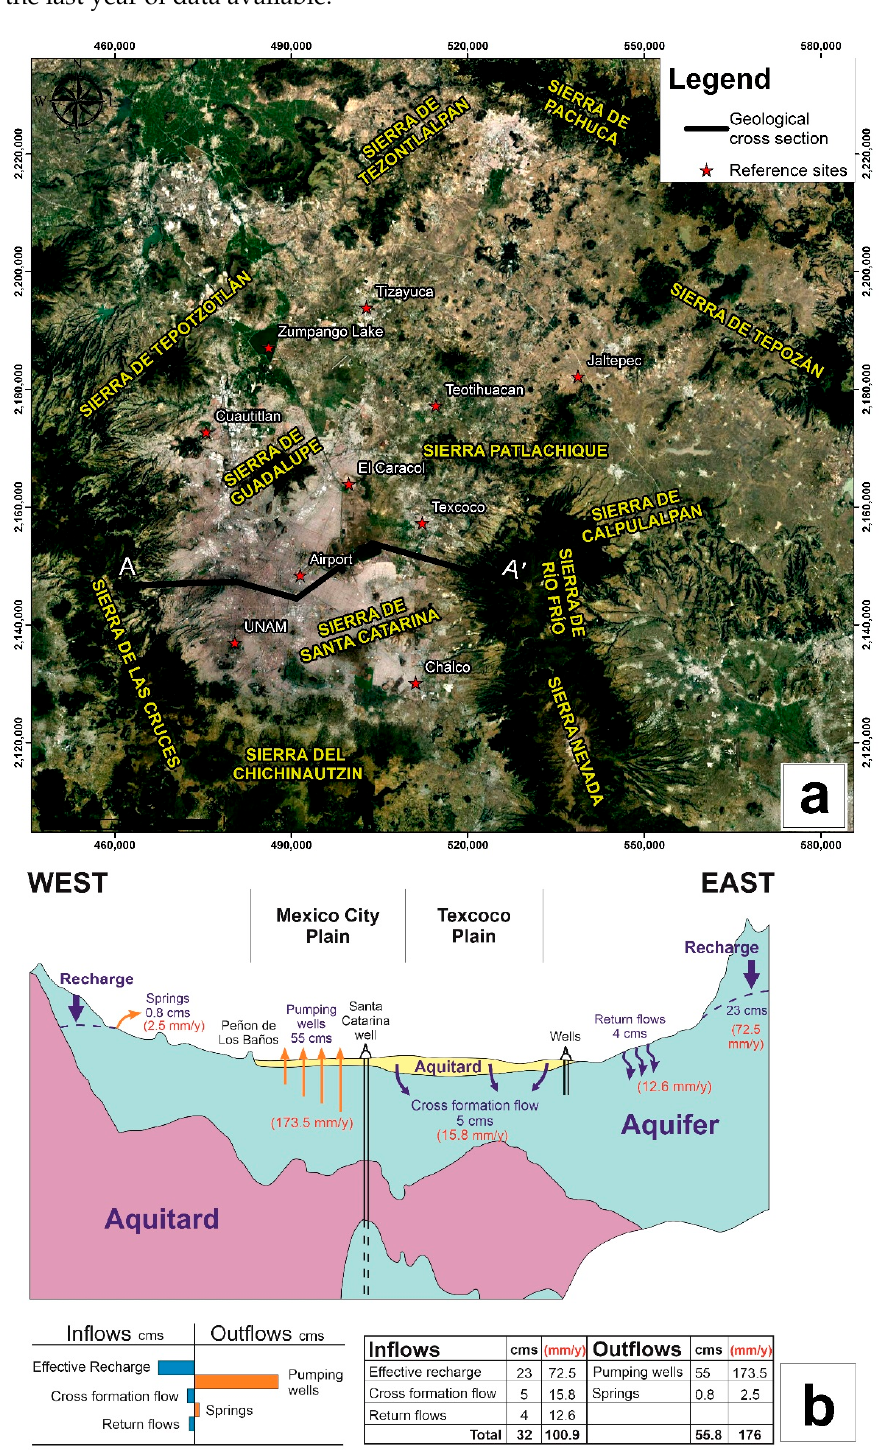
Figure 14. Detailed groundwater budget of the MBA in 2019: ( a ) satellite view of the Mexico City Metropolitan Area; ( b ) representative west-east cross section through the Plains of Mexico City and Texcoco. Values are representative of the whole MBA.